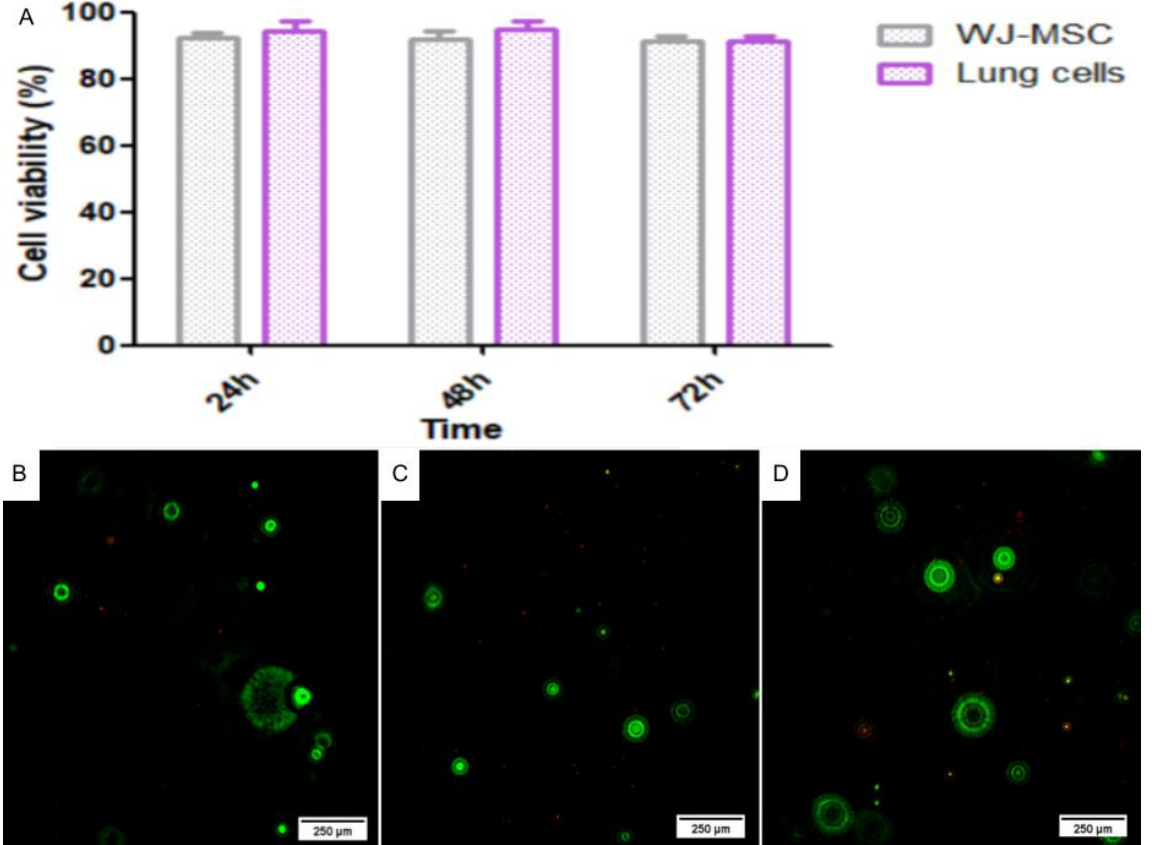
Figure 8. Live/dead assay of the lung 3D bioprinting. ( A ) Histograms indicating the viability of WJ-MSC (gray) and lung cells (purple) in the 3D structure after 24, 48, and 72 h of bioprinting. ( B ) Lung cell viability in the 3D structure after 24 h, with green live cells and red dead cells with 20× magnification. ( C ) Lung cell viability in the 3D structure after 48 h, with green live cells and red dead cells with 20× magnification. ( D ) Lung cell viability in the 3D structure after 72 h, with green live cells and red dead cells with 20× magnification. Images obtained using a high-throughput microscope In Cell Analyzer 2000 (GE Healthcare ® , Chicago, IL, USA).